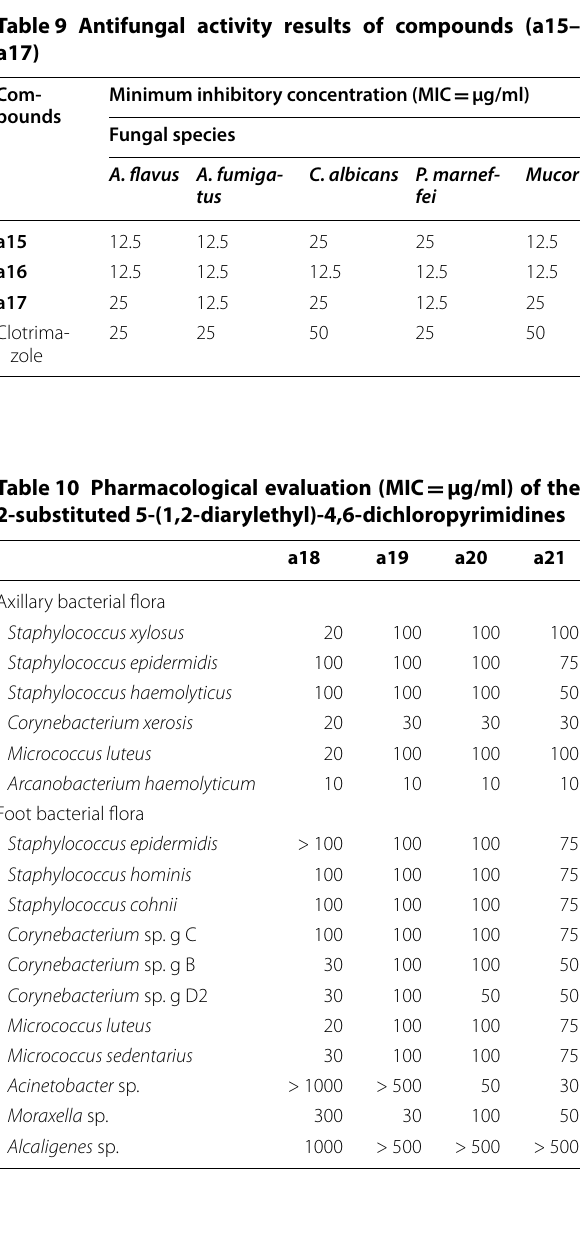
Table 9 Antifungal activity results of compounds (a15– a17)